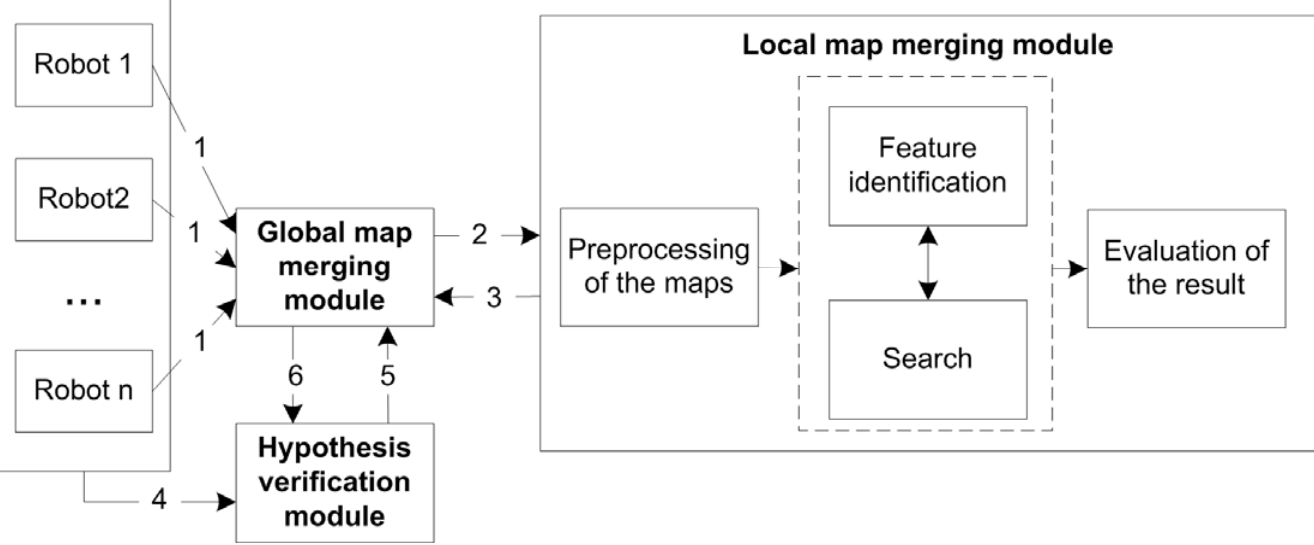
Fig. 10. The conceptual map merging model. Information flows represented in the Figure 10: 1) local maps of the robots and information about the relative position of the robots if the meeting occurs; 2) the maps to be merged and in some cases the relative position of the robots 3) and 6) map merging hypotheses (transformations) and messages about map merging failure; 4) local maps of the robots; 5) updated hypothesis